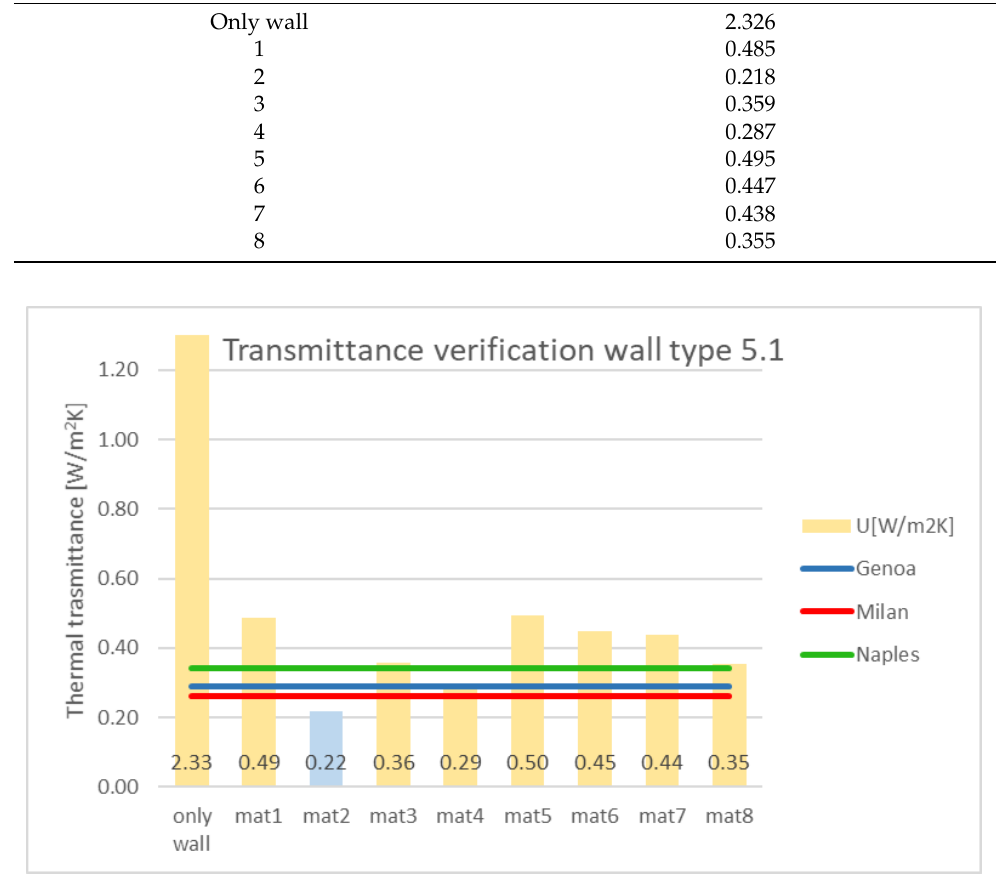
Figure A14. Wall type 5.1: transmittance check for the three main Italian climatic zones. In are blue the heat-reflective materials which respect all the limits.